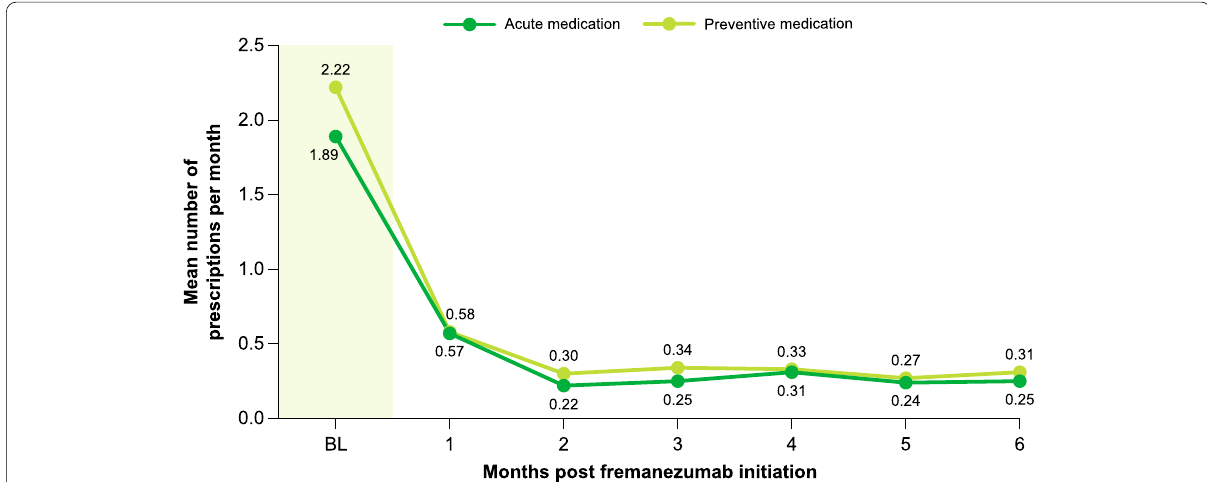
Fig. 3 Number of acute medication prescriptions analyzed via individual month post-fremanezumab initiation. BL baseline. P values calculated between individual months and baseline values via paired t-test. a P < 0.001